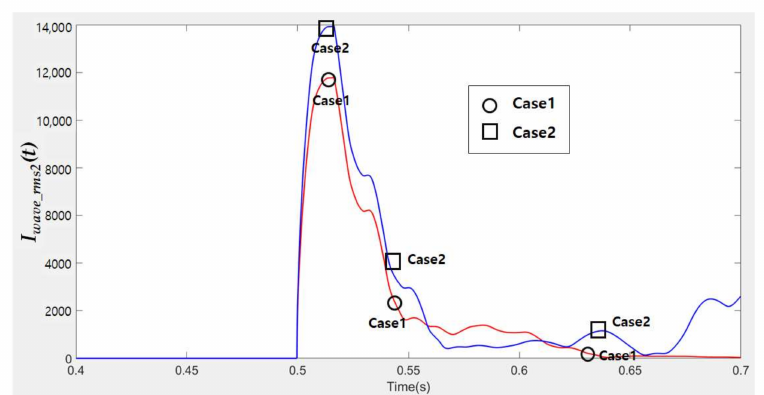
Figure 12. Comparison of I wave_rms 2 ( t ) in Cases 1 and 2.